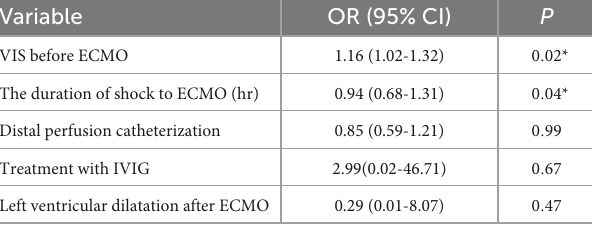
TABLE 5 Multivariate analysis: Logistic regression analysis of predictors of influencing survival rate for patients requiring ECMO for AFM.